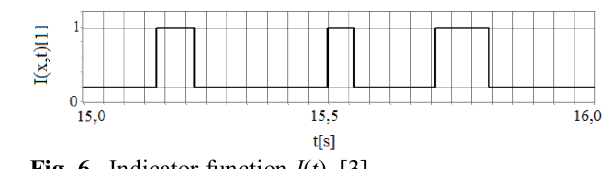
Fig. 6. Indicator function I ( t ),